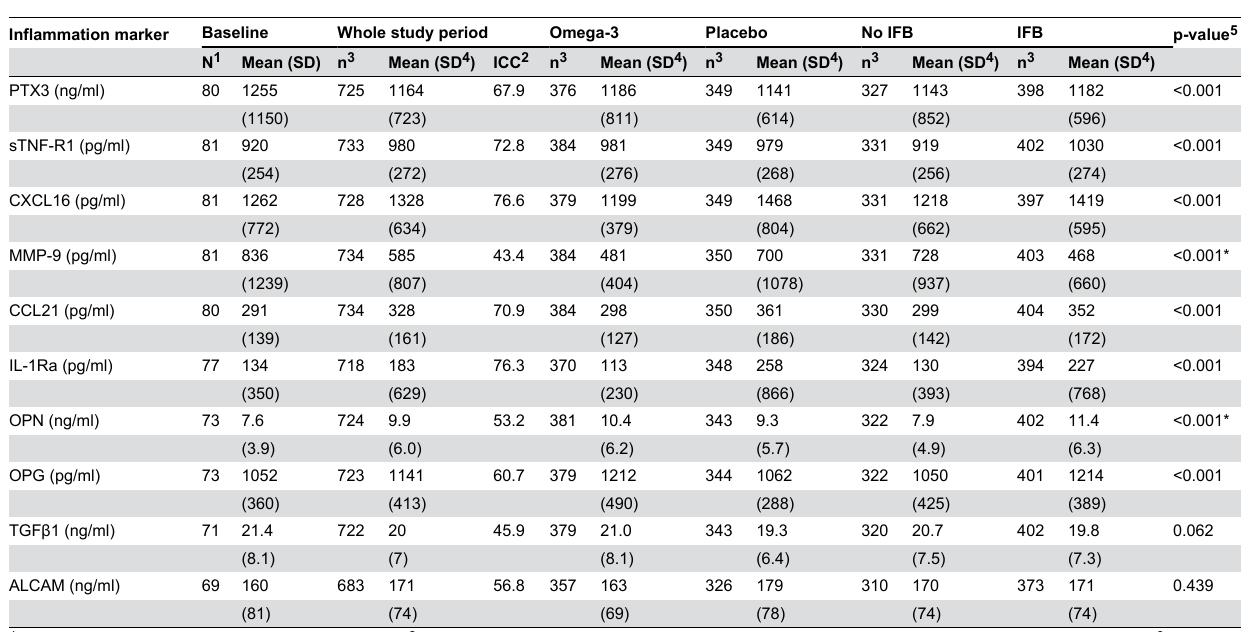
1 Number of patients with a baseline measurement; 2 ICC (%) is calculated for logarithmically transformed data with baseline measurements included; 3 Number of measurements in the analyses; 4 Calculated ignoring clustering; 5 p-value from the model from mixed model with random intercepts and heteroscedastic residuals where relevant (irrelevant indicated with *) for logarithmically transformed measurements